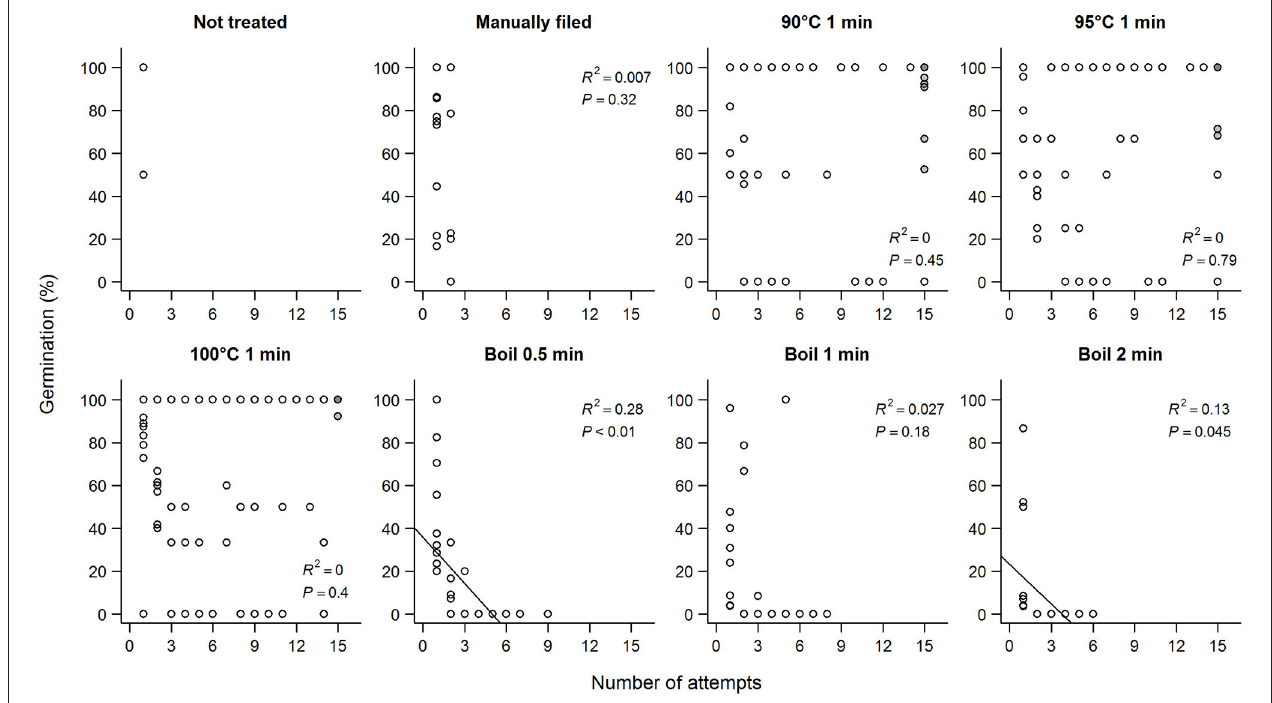
FIGURE 4 | Germination percentage of koa seeds and the number of attempts each scarification treatment took for seeds to imbibe. Each circle represents a mother tree, and the filled circles are seeds that did not imbibe after the 15th attempt and were subjected to manual filing afterwards. Data for each subpanel are for seeds from nine trees subjected to all scarification